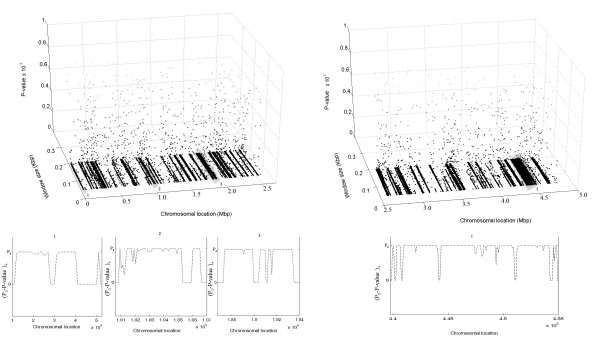
In the upper panel, 3D plots of the P-values for a window with variable size that slides across (i) the chromosome of Salmonella typhi CT18 from 1 bp, i.e., the start to 2.5 Mbp (Fig. 3A), (ii) the chromosome of Salmonella typhi CT18 from 2.5 Mbp to 4.8 Mbp, i.e., end (Fig. 3B). The P-value at a specific location and for a specific size of the window is plotted using a gray scale that changes gradually from black to white with black corresponding to the extreme P-value = 0 and white corresponding to the other extreme P-value = 1. The white dots corresponding to higher P-values are almost invisible in the white background while dark dots corresponding to low P-values are prominently visible marking the GIs in the chromosome. Lower panel in each figure gives some representative 1D plots generated from the refinement phase for some of the 'putative GIs' (enclosed in gray blocks and labeled as 1,2,... in the 3D plots) detected in the first phase of Design-Island. The quantity (P0-P-value)+ for the region of a GI detected in the first phase is plotted. Here, for P-value > P0, (P0-P-value)+ = 0, and for P-value < P0, (P0-P-value)+ = (P0-P-value).